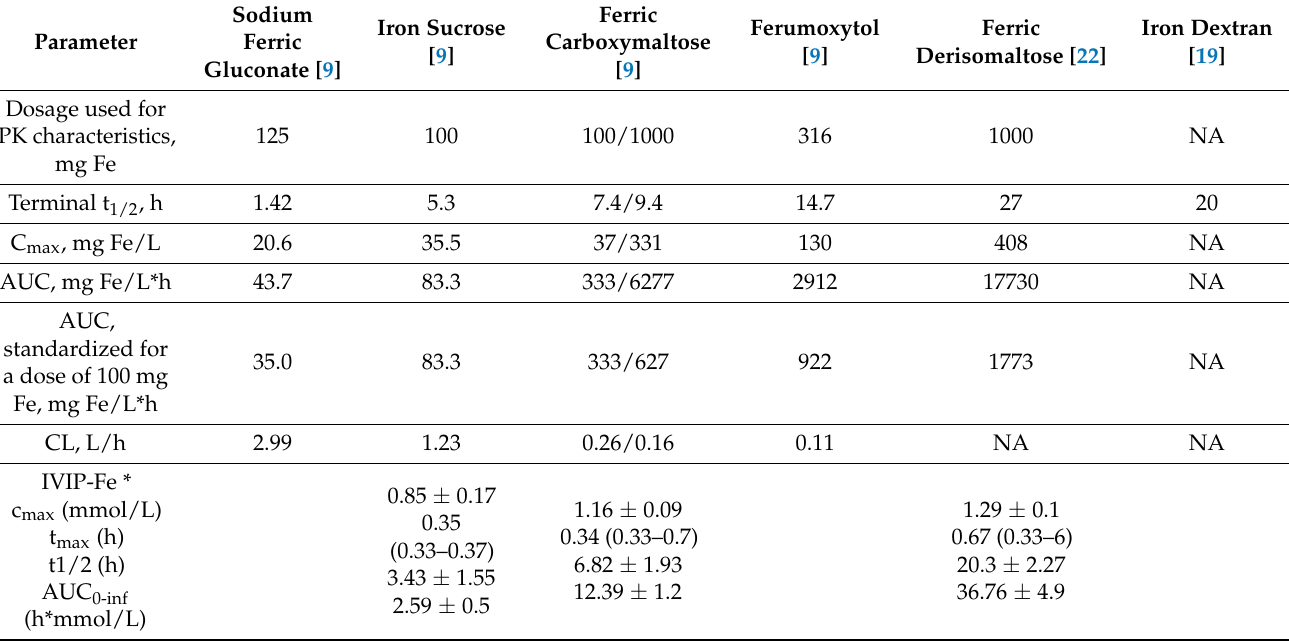
Table 5. Pharmacokinetic parameters of intravenous iron–carbohydrate